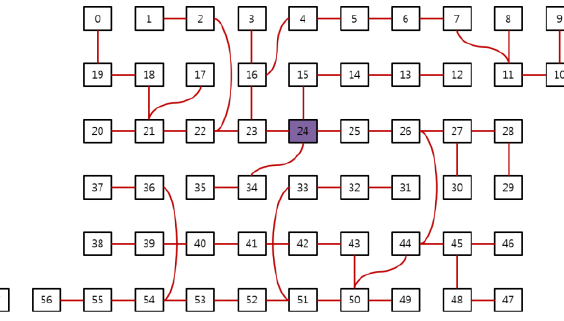
Figure 3. Maximum spanning tree with experiment dataset